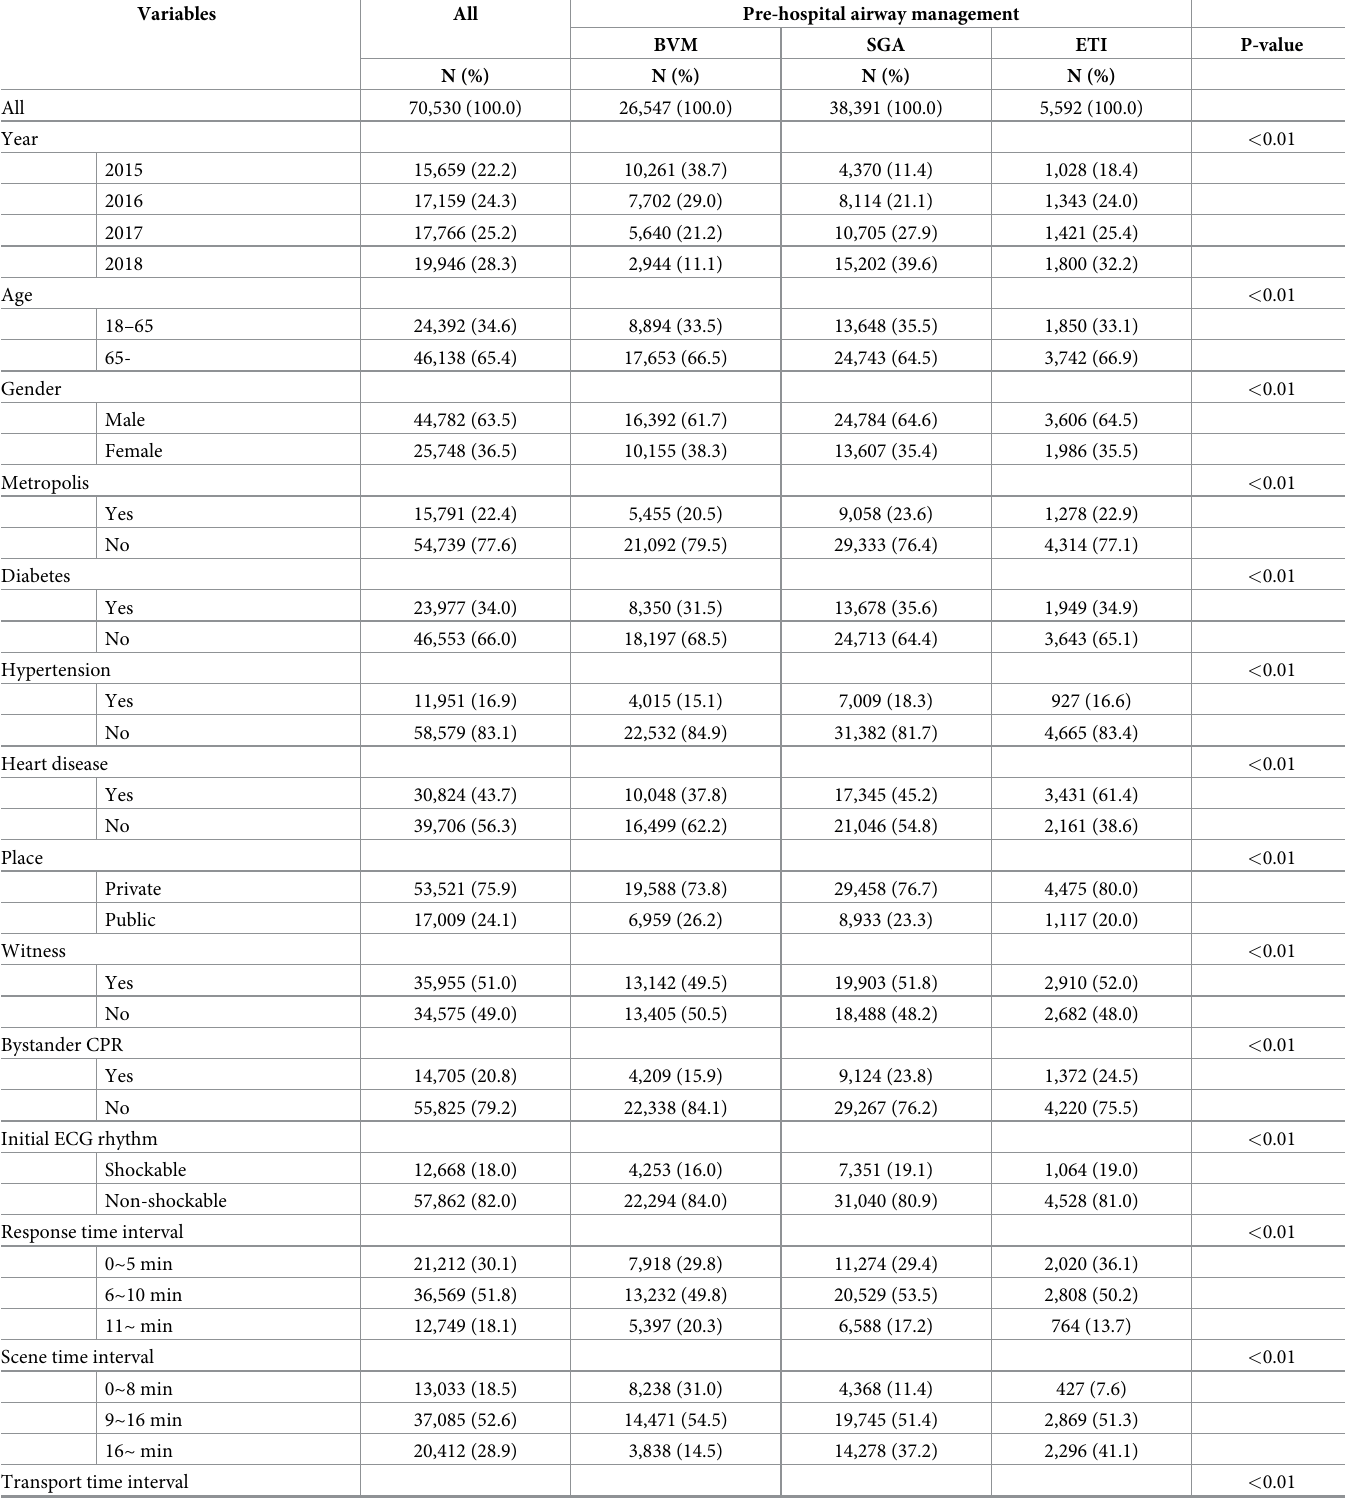
Table 1. Characteristics of out-of-hospital cardiac arrest patients by airway management techniques.